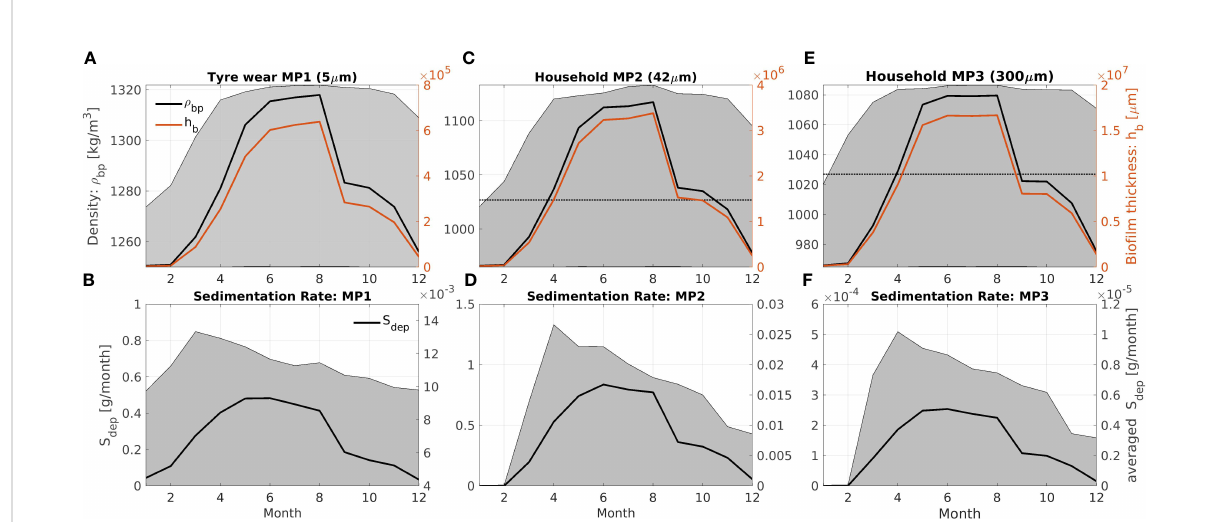
FIGURE 3 Monthly climatology (6-year data set: 2014 – 2019) of average bio fi lm thickness (red), density (black, panel A – C ), and the range of density values (shaded areas) for tire wear microplastics MP1 (A, B) and household microplastics MP2 (C, D) and MP3 (E, F) . The dotted line marks the density of sea water. Average, minimum, and maximum sedimentation rates are provided (black, panel B, D, F ). Sinking velocities have been recalculated using kinematic